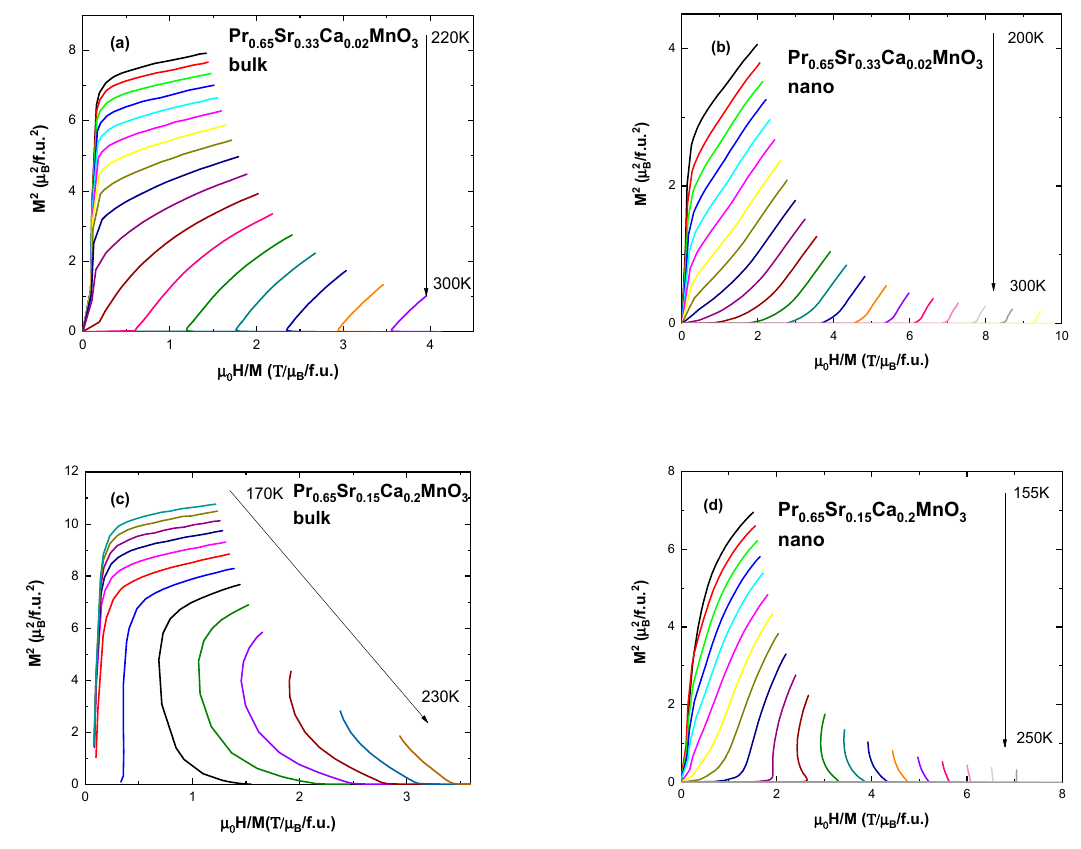
Figure 7. Arrott plot ( M 2 vs. H/M ) for ( a ) the bulk sample with x = 0.02; ( b ) the nanocrystalline sample with x = 0.02; ( c ) bulk sample with x = 0.2; ( d ) nanocrystalline sample x = 0.2.